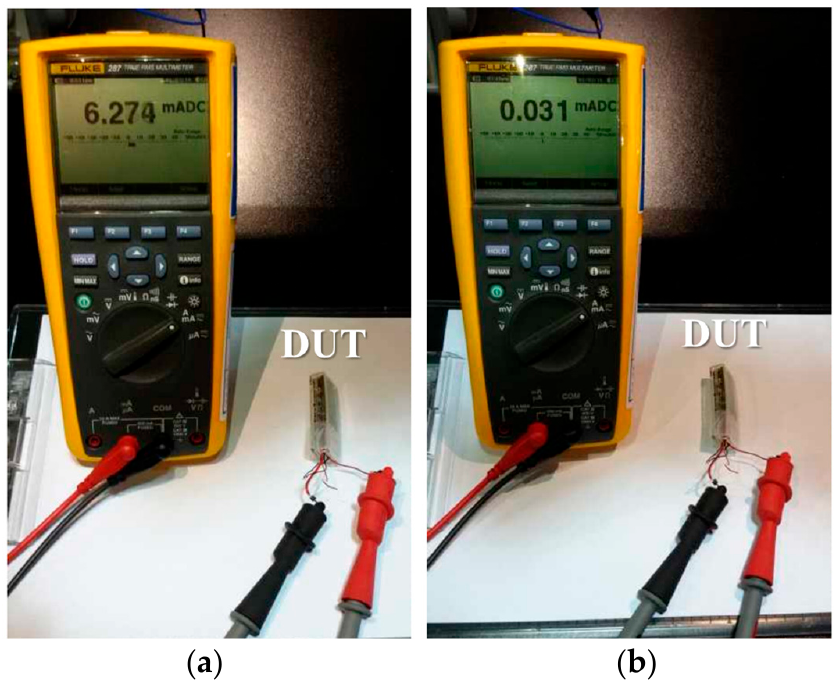
Figure 12. Experiments for measuring the power consumption ( a ) in the active mode and ( b ) in sleep mode.